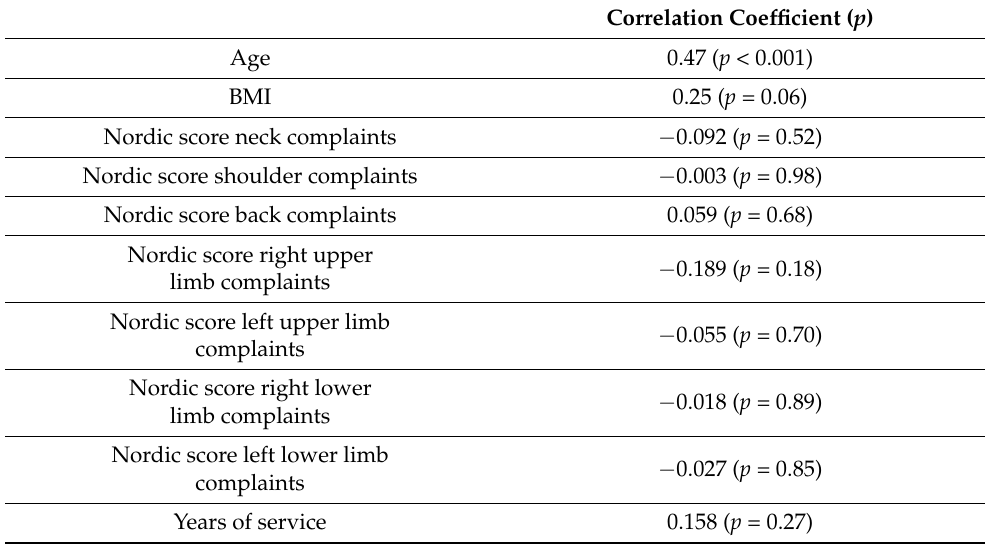
Figure 1. Reaction time by gender and lead exposure status. Age and body mass index had weak positive correlations with reaction times (Table 2). Years of service and the Nordic scores had very weak correlations with the reaction time, but their correlation was not statistically significant. Thus, we only include age and body mass index as confounding factors in examining the difference of reaction time be- tween lead-exposure and no lead-exposure jobs. Table 2. Correlates of reaction time.